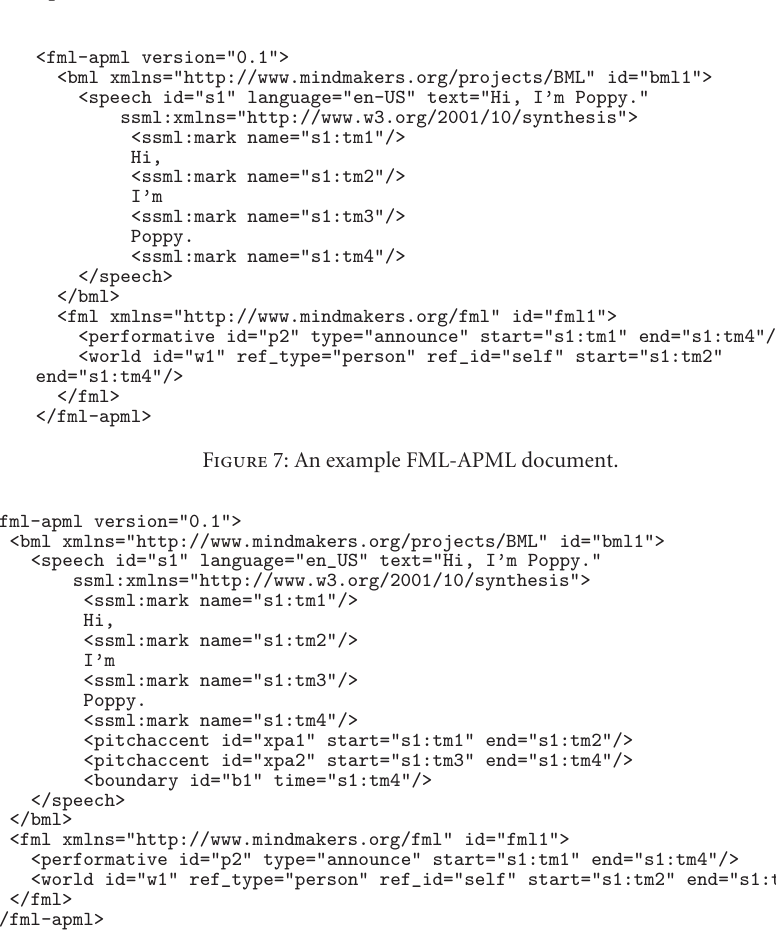
Figure 8: Pitch accent and boundary information added to the FML-APML document of Figure